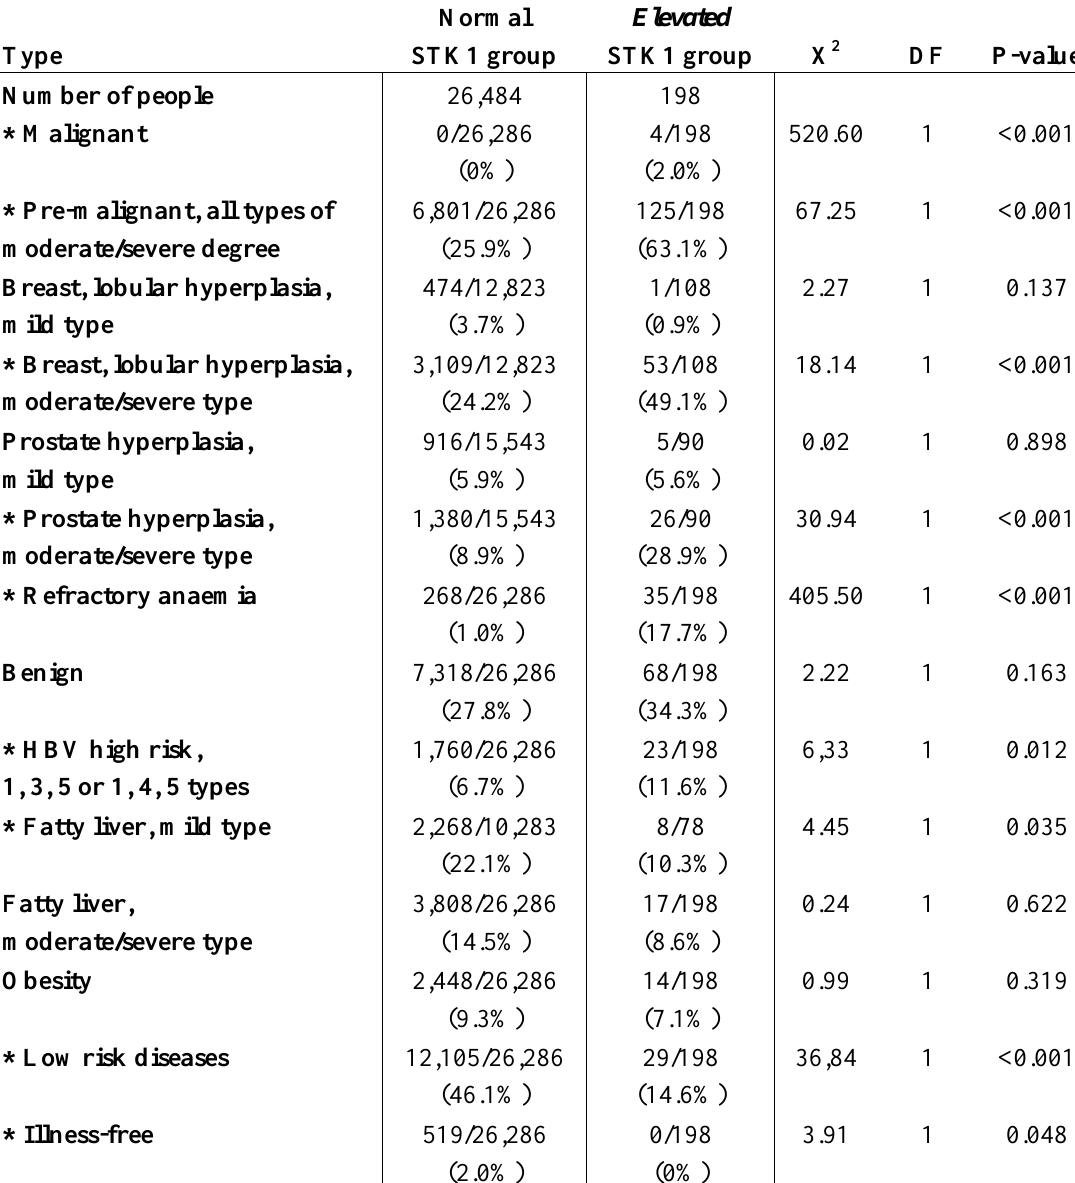
Table 4. Number of city-dwelling people of the normal and elevated STK1 groups of various diseases. The malignancies in the elevated STK1 group were of early tumour stage. The low-risk diseases consist of HBV score types 2, 4, 5 or 2, 5; mild degree of hyperplasia; cervical erosion; gastric ulcer; and fatty liver of low risk. The illness-free group was defined as no detectable diseases or illness. The statistical calculations were done by chi-square test. The stars ( * ) indicate groups of statistically significant